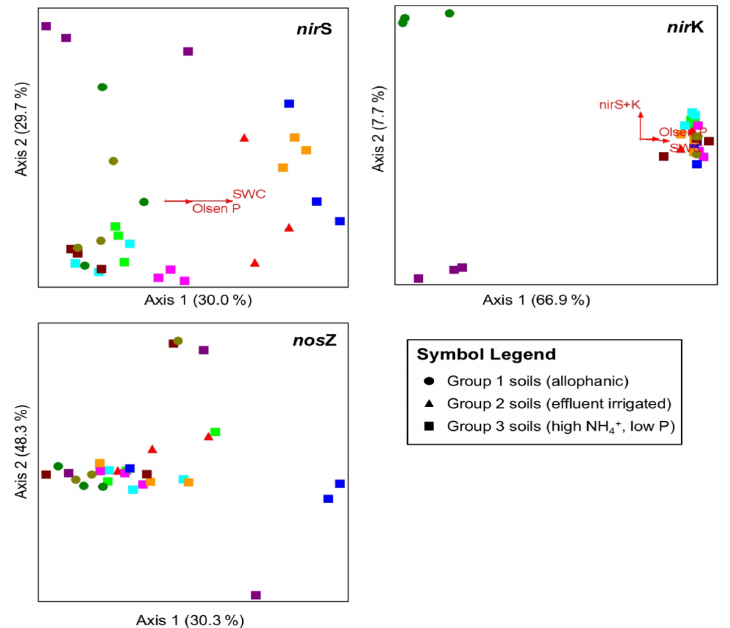
Figure 3. Non-metric multidimensional scaling (NMS) ordinations illustrating the Bray–Curtis dissimilarities of nir S, nir K, and nos Z com- munities. Vectors represent those factors that were significantly correlated with the first and second ordination axes at τ = 0.2. Symbol colours are the same as in Fig. 1. Symbol shapes represent the three groups of soils as determined by the PCA of their physiochemical characteristics (Fig. 1). Final stress values for ordinations nir S 12.53, nir K 5.58, and nos Z